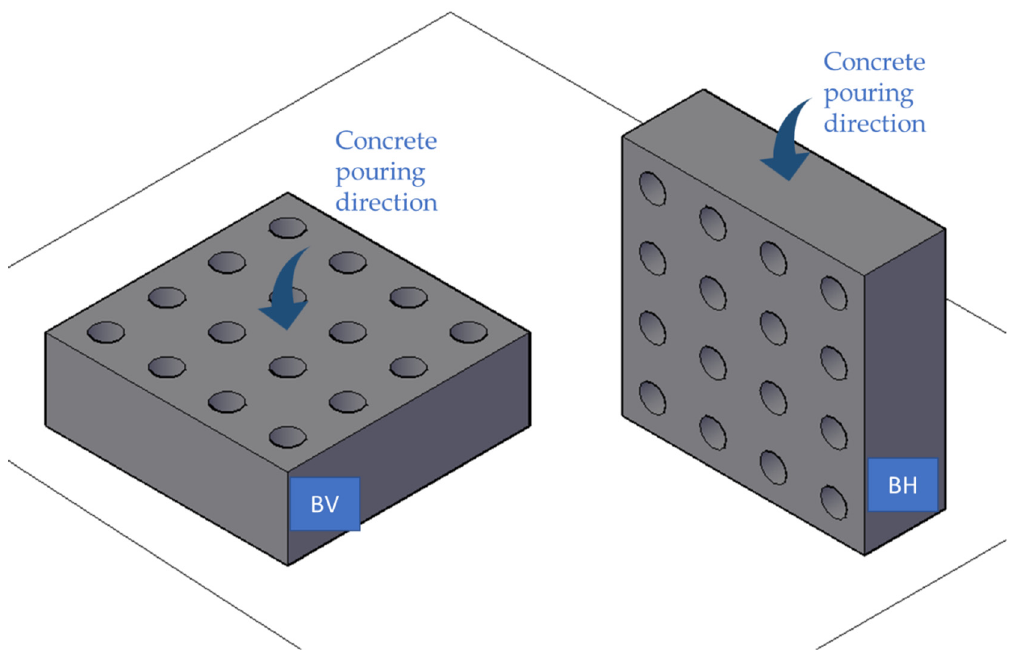
Figure 5 . Concrete pouring directions in each block. Figure 5. Concrete pouring directions in each